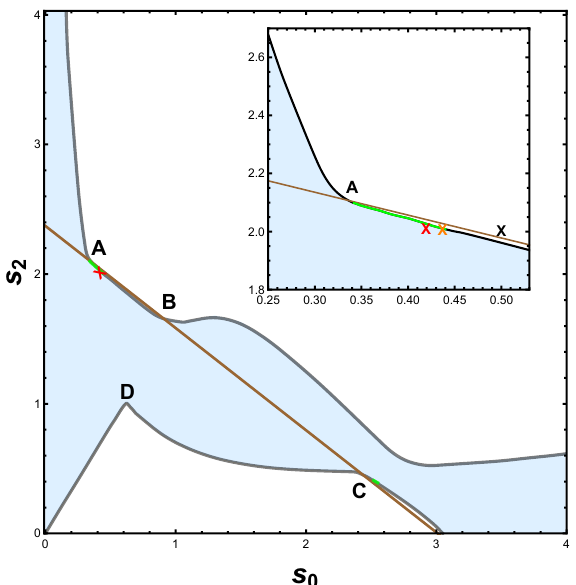
Figure 1: Pion river at N max = 16. The behaviour changes rapidly at points A,B,C and D. The red cross marks the two-loop χ PT . The brown straight line is the Lovelace- Shapiro model allowing for general Adler zeros. The green regions(near regions A and C) exhibit linearity. The inset shows a zoomed version with the tree-level, one- loop and two-loop χ PT values indicated in black, orange and red